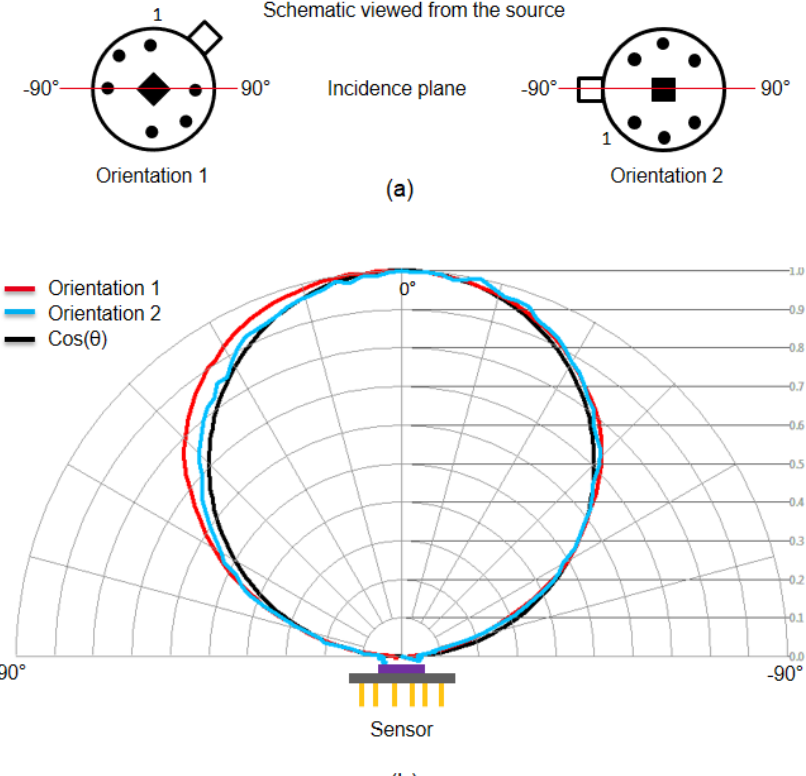
Figure 7. ( a ) Considered orientations of the thermopile sensor; ( b ) photo-metric